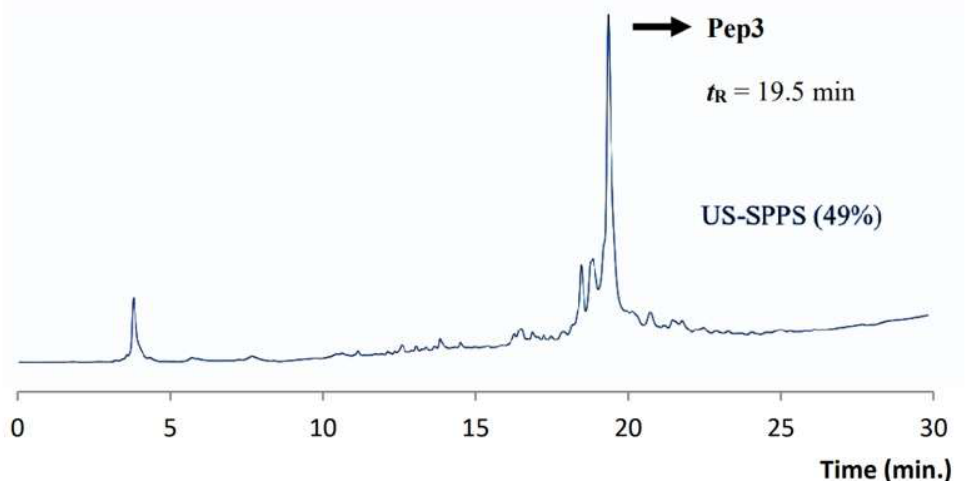
Figure 6. Analytical RP-HPLC chromatogram obtained for crude Pep3 ( t R = 19.5 min). Gradient C (see experimental section).